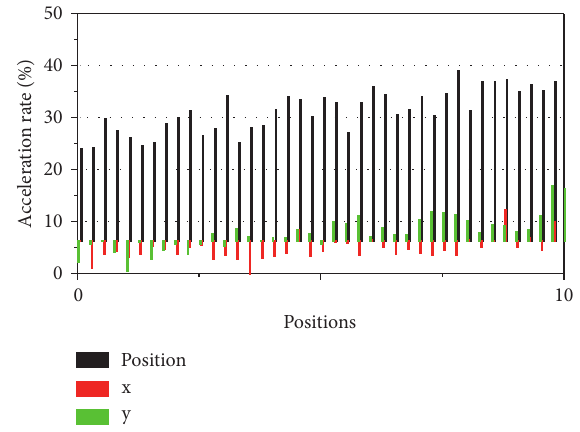
Figure 7: Modular acceleration